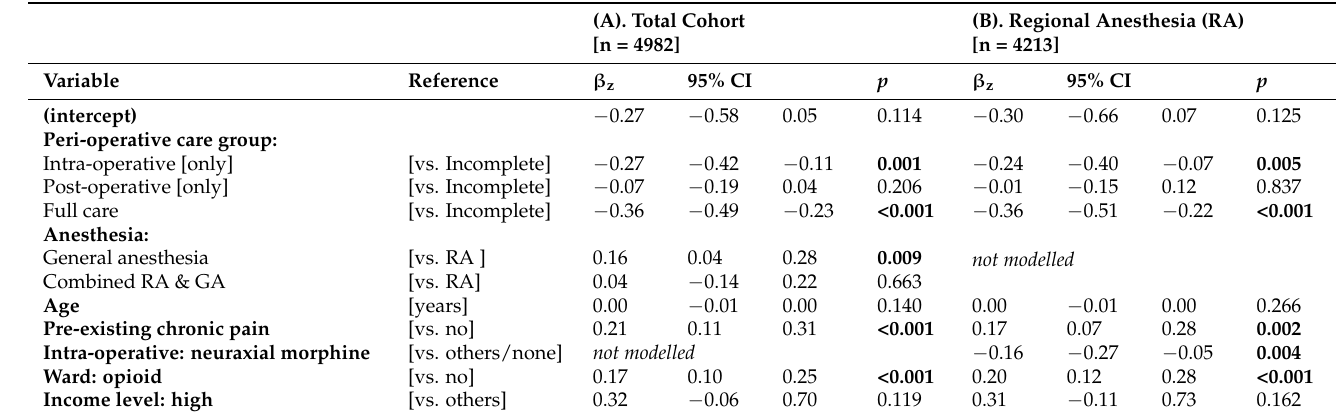
Table 3. Results: the Pain Composite Score, total (PCS total ), was used as the dependent variable in multivariable, multi-level regression models in (A) results for the total cohort and (B) for women with regional anesthesia. Standardized regression coefficients ( β z ) including 95% confidence intervals (95% CI) and p -values ( p ), are shown. Significant p -values are printed in bold.